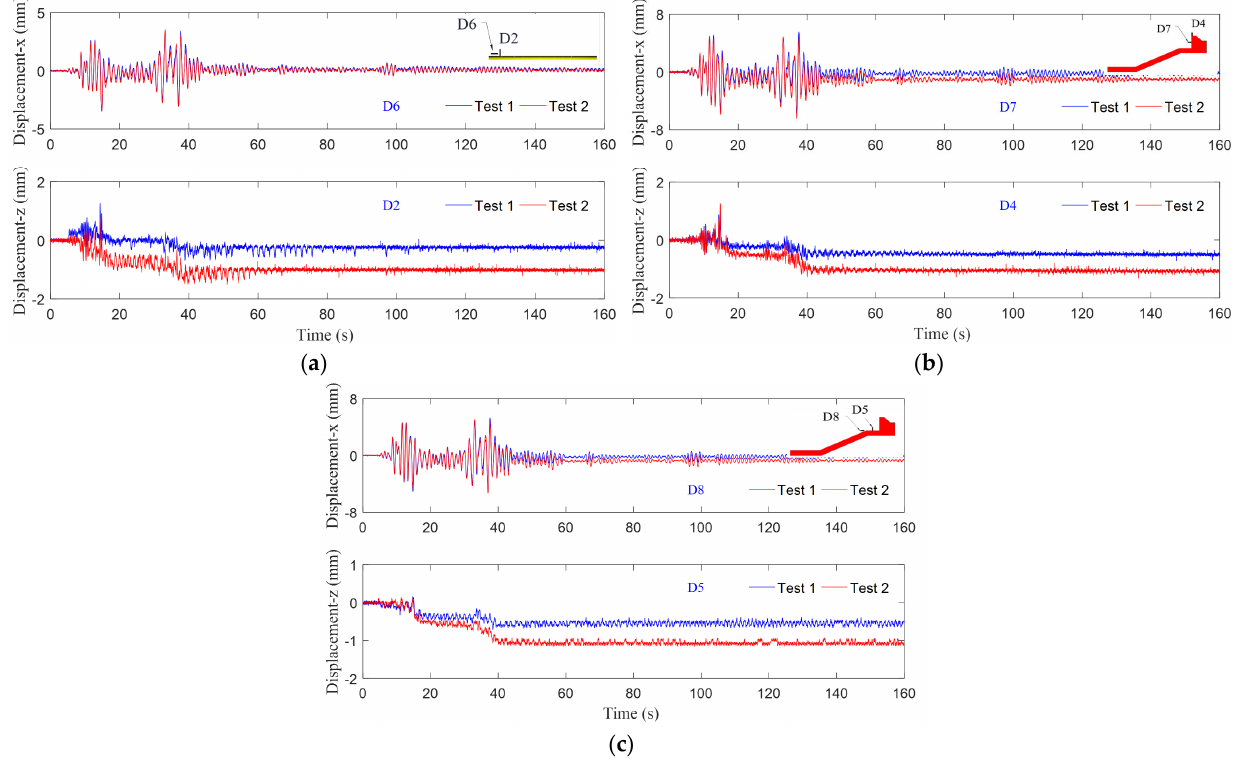
Figure 13. Comparisons of displacement responding at typical positions in Test 1 and Test 2. ( a ) Runway. ( b ) Caisson. ( c ) Revetment.